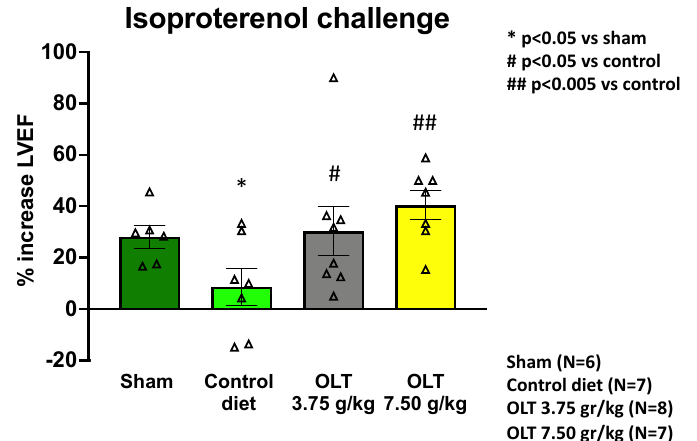
Figure 4. LVEF contractile reserve assessment at 10 weeks after the non-reperfused MI surgery shows that the mice treated with OLT1177 (3.75 g/kg and 7.50 g/kg) had a significant % increase in LVEF following the isoproterenol challenge, reflecting an increase in the β -adrenergic response/contractile reserve. Each triangle corresponds to the value measured in each mouse. The values are expressed as the mean ± SEM.